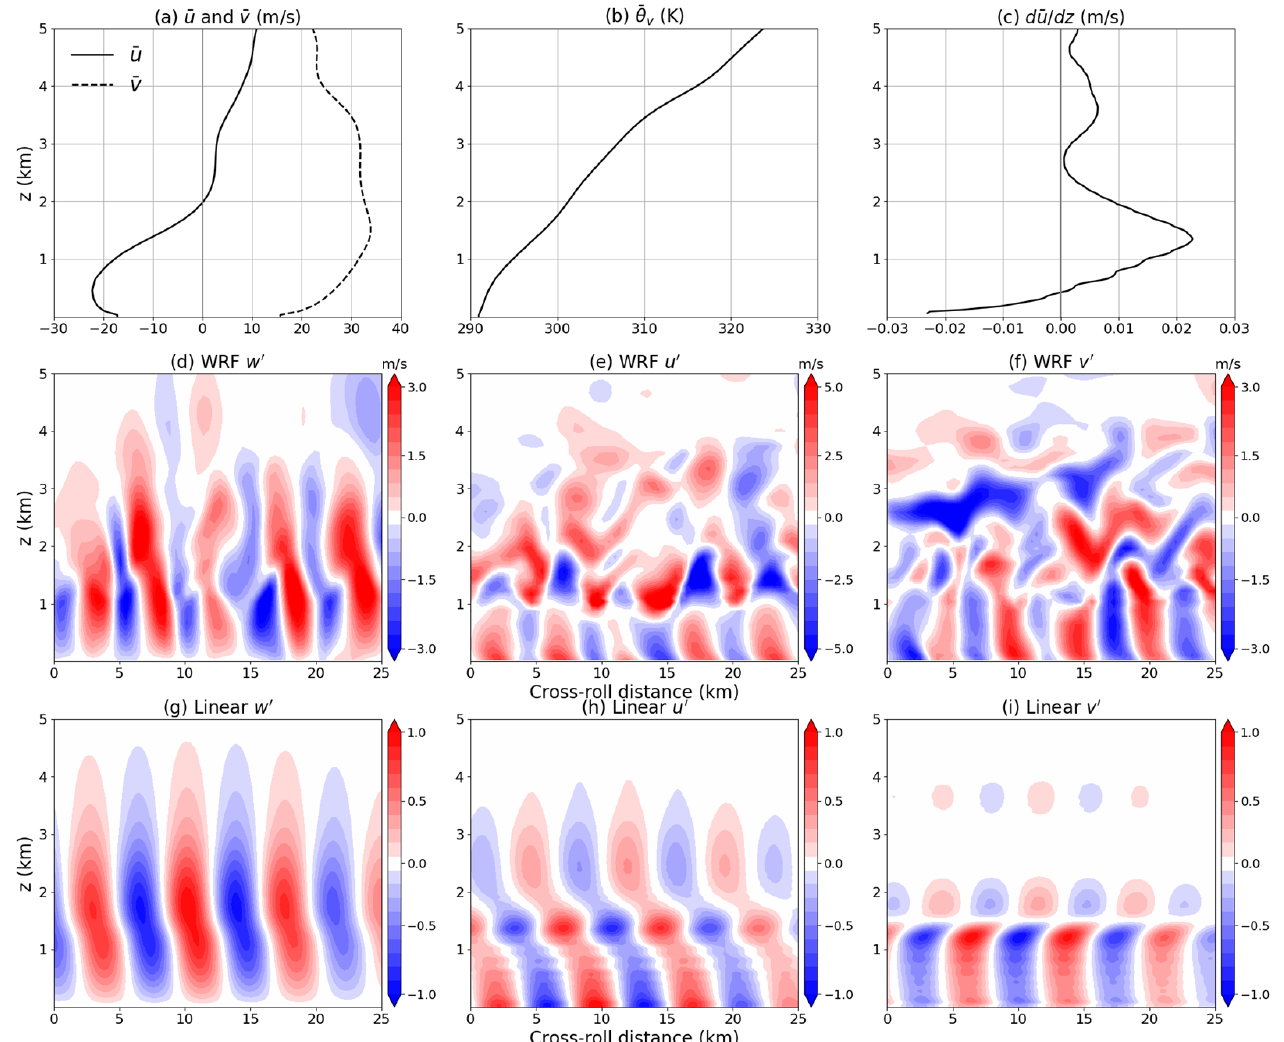
Figure 9. Simulated roll structure at 0000 UTC 30 October 2012 for transect line shown in Figure 6c. The radial ( u ) and tangential ( v ) wind components are projected onto storm-centered cylindrical coordinates. Figure ( a – c ) shows area-averaged vertical profiles of horizontal velocity components, virtual potential temperature, and radial wind shear, respectively, from the WRF simulation. Figure ( d – f ) shows cross sections of vertical, radial, and tangential velocity perturbations associated with rolls, respectively. Figure ( g – i ) shows cross sections analogous to those shown for WRF except that they are from the linearized roll model. The cross sections extend outward from the storm center so the 0 and 25 km end points represent the east-northeast (ESE) and west-northwest (WNW) transect end points,